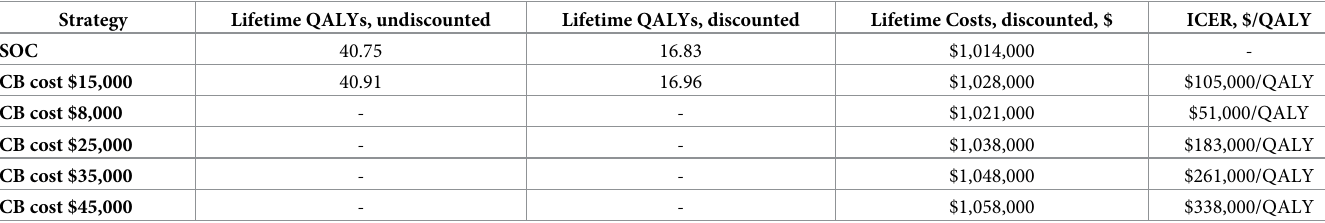
Table 2. Lifetime societal costs and quality-adjusted life years. Strategy Lifetime QALYs,